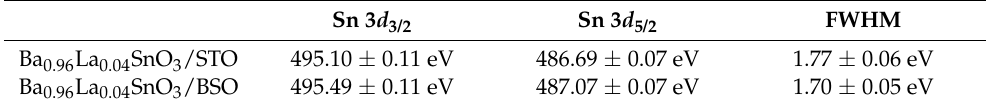
Table 1. The Sn 3 d core level of La 4% doped BLSO film deposited on STO and BSO substrates.